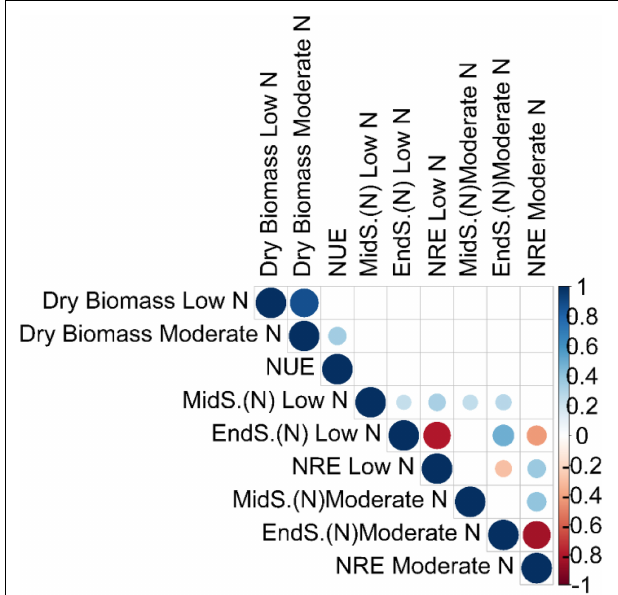
FIGURE 1 | Correlation analysis among the NUE and the related traits. Pairwise Pearson correlation analysis between NUE and related traits was performed using the best linear unbiased predictions (BLUPs) of the switchgrass diversity panel. The correlation matrix was visualized in R v.3.4.3 (R Core Team). Each dot represents a significant correlation coefficient (r) at false discovery rate (qFDR) values < 0.05. Blue dots indicate a strong positive correlation, while light blue indicates a moderate positive correlation. Similarly, red dots indicate a strong negative correlation, while orange indicates a moderate negative correlation. The stronger the correlation (positive or negative), the bigger are the blue and red dots, respectively, and vice versa . MidS.(N) and EndS.(N) indicate the % of N content in tillers at the mid season and the end of season, respectively. The unit of dry biomass is Kg; NUE (nitrogen use efficiency) is Kg Kg/m2; and NRE (nitrogen remobilization efficiency) is % (percent of